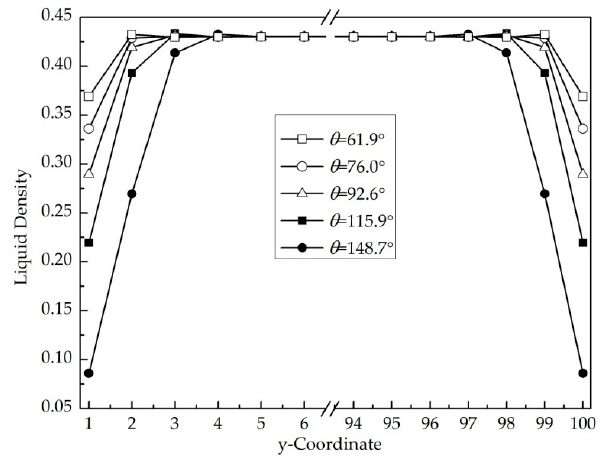
Figure 9. Liquid density profiles for different contact angles.